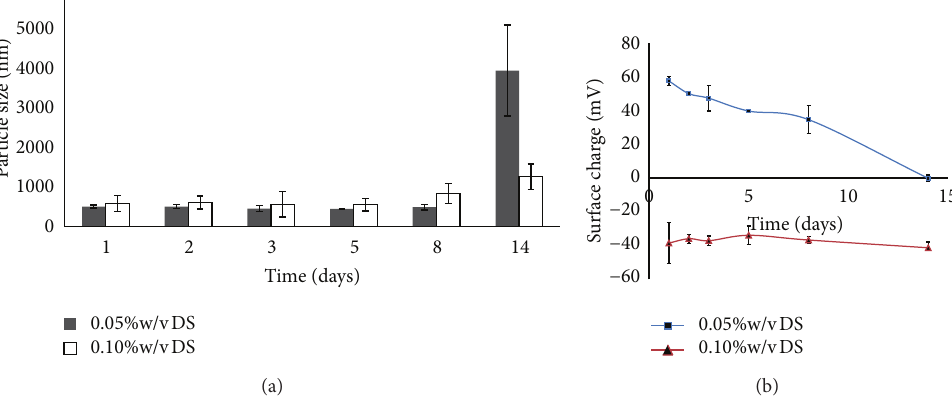
Figure 3: (a) Particle size and (b) surface charge of CS NPs prepared at 0.05 and 0.01%w/v DS solution and stored at 25 ∘ C. Nanoparticles were suspended in distilled water (pH in the range of 6-7), 𝑛 = 3 .